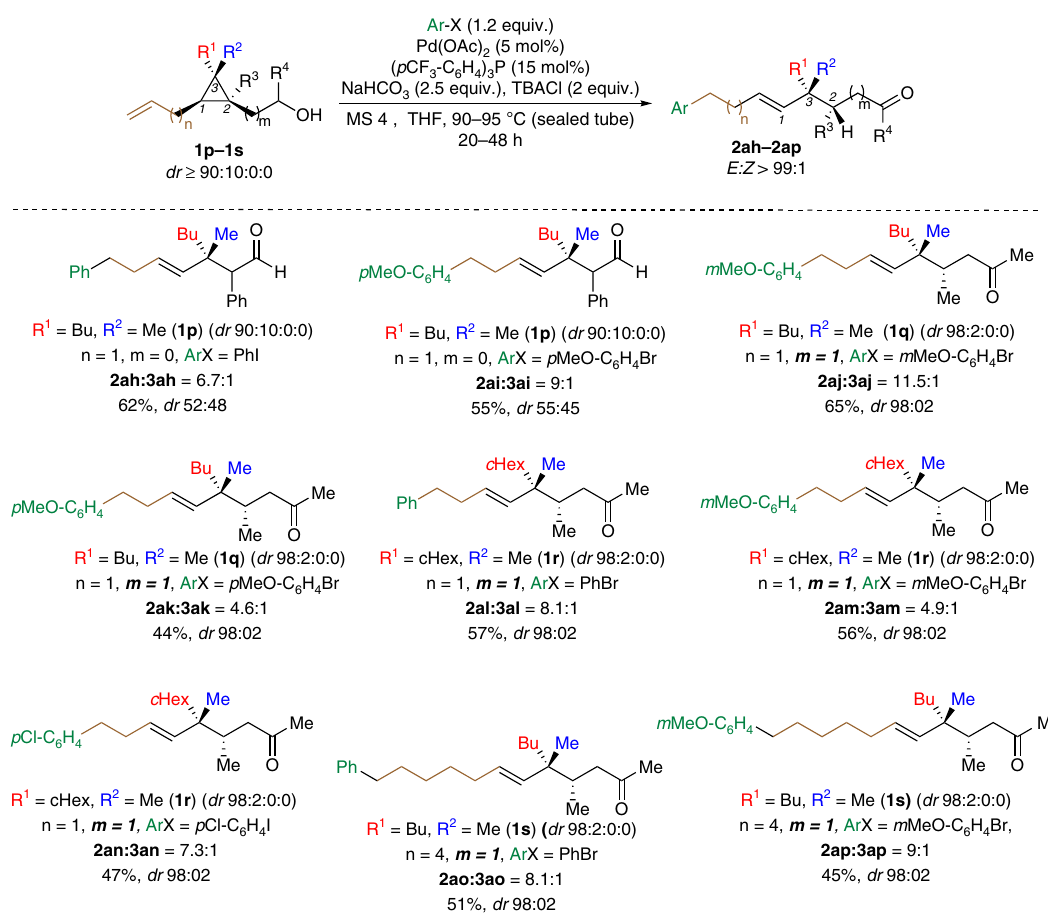
Figure 5 | Scope of the chain lengths (n and m) and substitution. Remote Pd-catalysed Heck triggered ring-opening in 1,2,2,3,3-pentasubstituted cyclopropane derivatives ( 1p – 1s ). The relative configuration of 2aj was confirmed by X-ray analysis of the corresponding hydrazone 4 (see Supplementary Fig. 91). Relative configurations of other major products 2aj – 2ap were assigned by analogy. The described yields are the combined yields of both regioisomers after purification by column chromatography. Regioisomeric, diasteromeric and E/Z ratios were determined by NMR and GC analyses of the crude